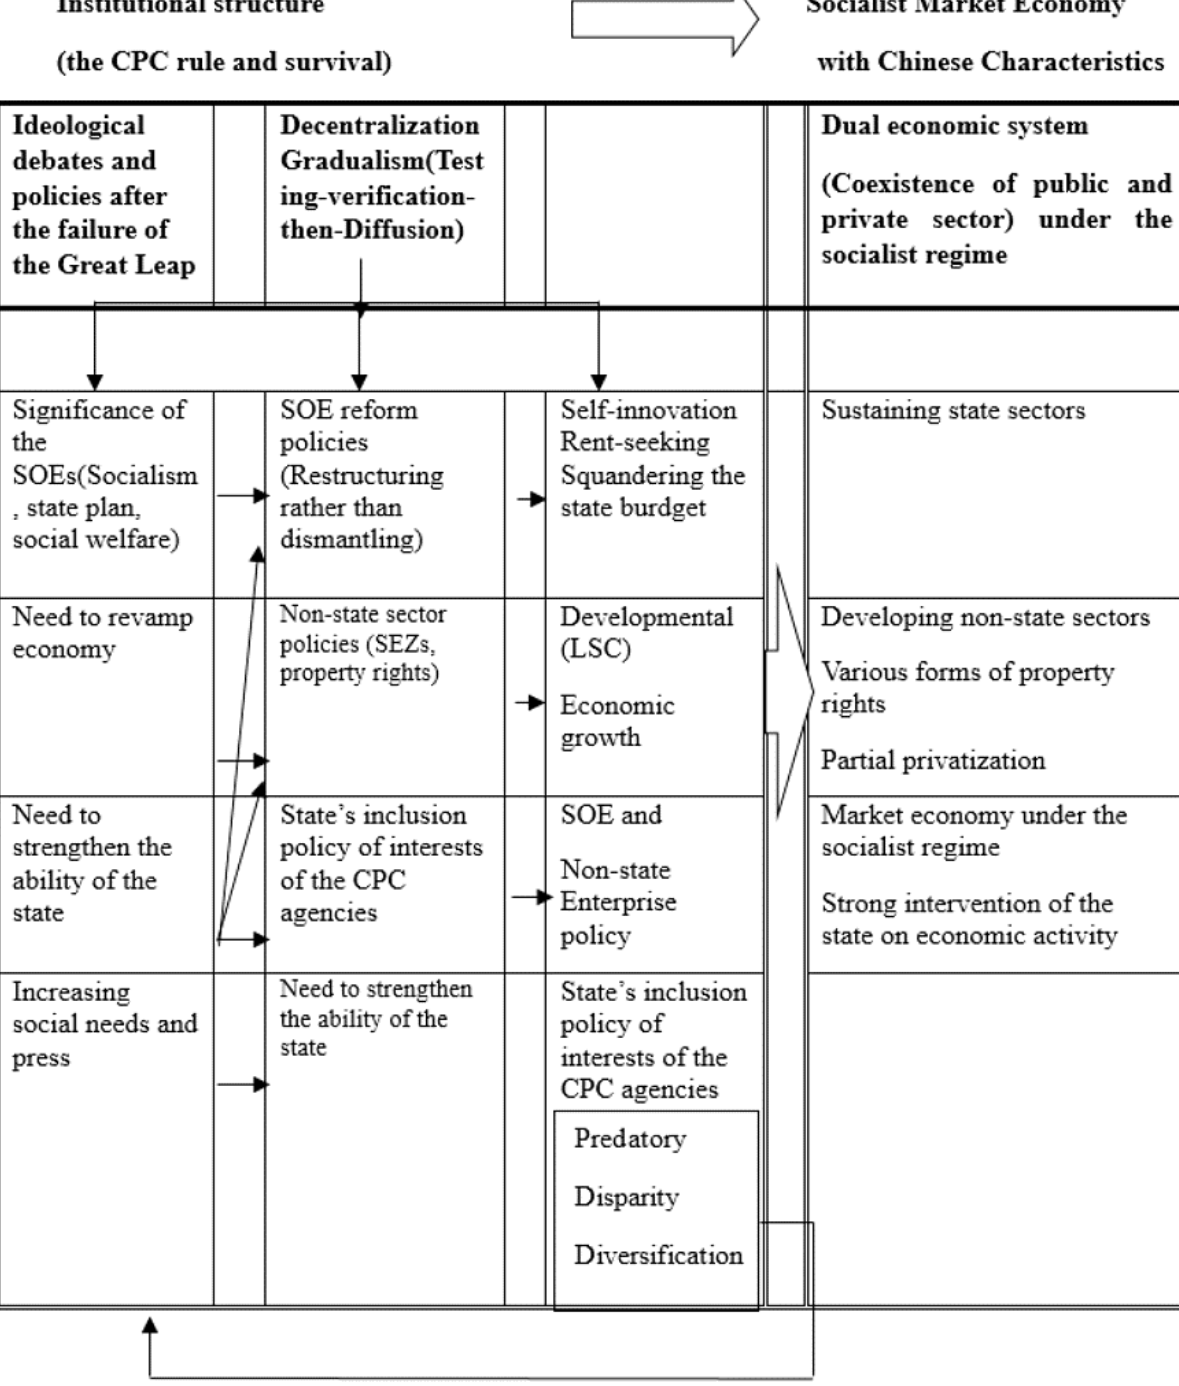
Figure 2. Institutional processes of market economy in China